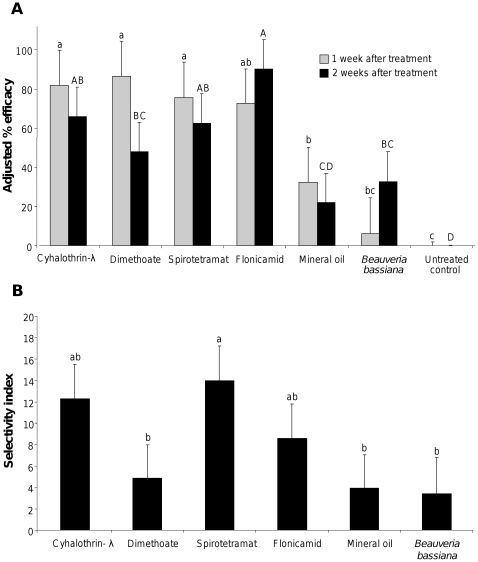
Field efficacy and selectivity observed for six insecticides for aphid control.
A) Observed efficacy. Aphid count data were Henderson-Tilton adjusted [32] and subjected to a mixed model ANOVA by post-treatment sampling period with year of experiment, block, pass of tractor, site, and interaction terms between block and pass, block and site, and pass and site incorporated into the model. b) Observed selectivity. Field selectivity was determined using the natural enemy-to-aphid ratio in treatment plots, for exact calculation see Materials and Methods. Observed efficacy and selectivity within sampling period marked by the same letter are not significantly different at α = 0.05 (LSD).